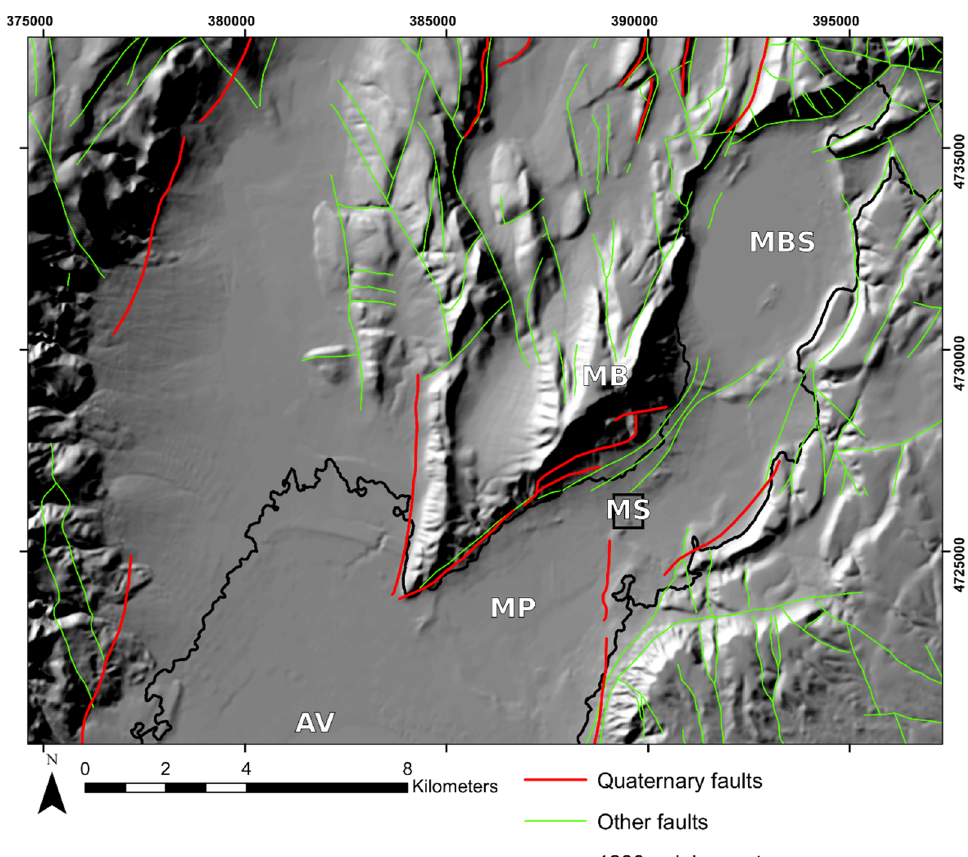
Figure 2. Mickey Basin (MBS) is a sub ‐ basin extending to the NE from the Alvord Valley (AV). Mickey Butte (MB) is part of the horst block that separates the two arms of the Alvord Valley. Mickey Springs (MS) is directly southeast of Mickey Butte. A third sub ‐ basin, here called Mickey playa (MP), is southwest of Mickey Springs. Several Quaternary faults have been mapped (red lines), and some have offset shorelines from pluvial Lake Alvord (1280 m shoreline indicated by black line). Several other faults have been mapped in the vicinity of varying age (green lines). Fault data are from